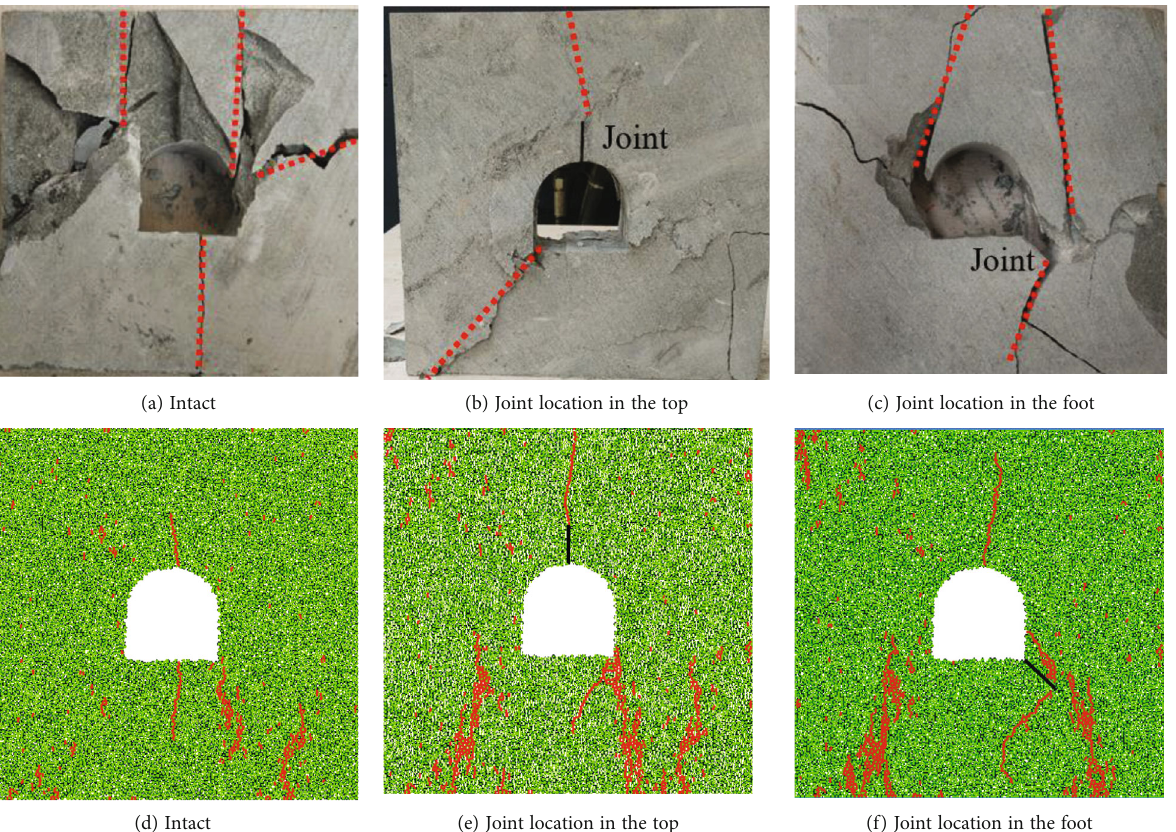
Figure 14: Experiment and numerical